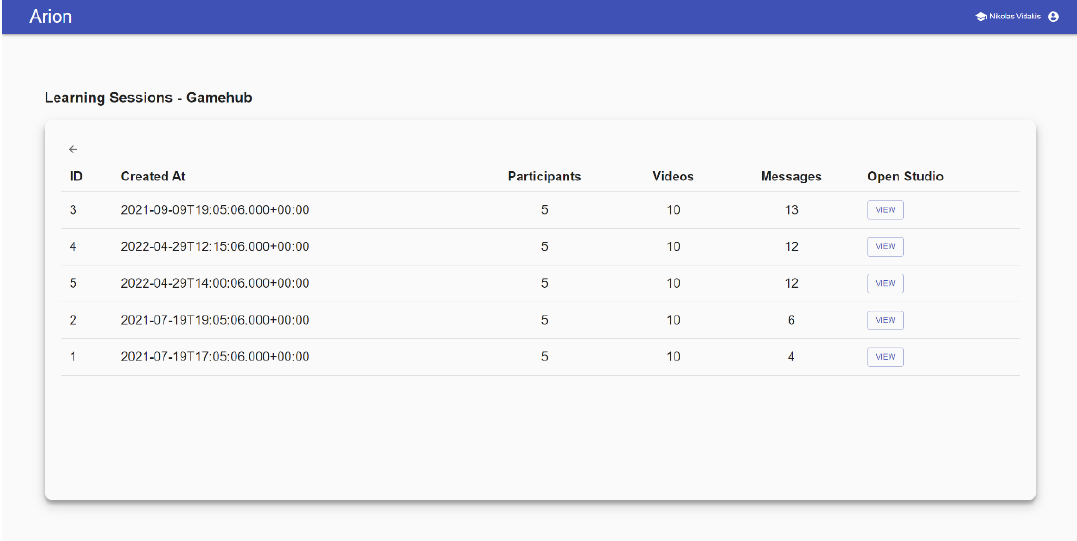
Figure 5. Available Class Learning sessions.